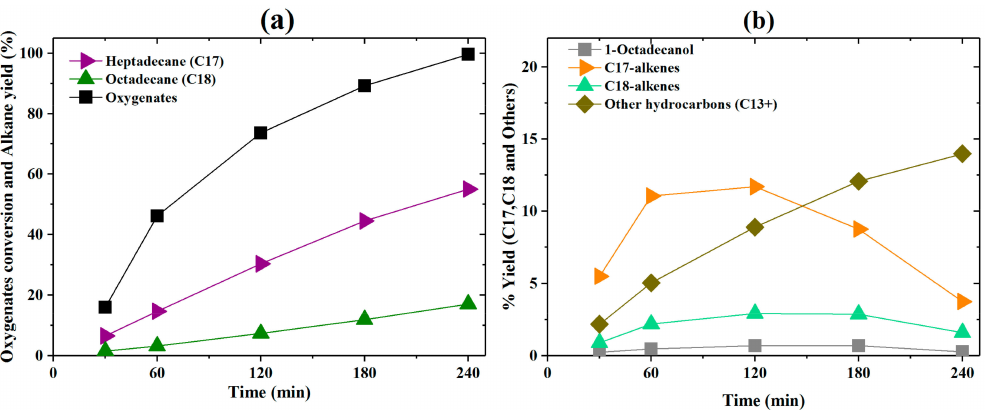
Figure 1. Products and reactant profile during the reaction at 54 bar, 320 ◦ C, and 0.3 mL dimethyl disulfide (DMDS), ( a ) oxygenates conversion, C17 and C18 yield, ( b ) other products and